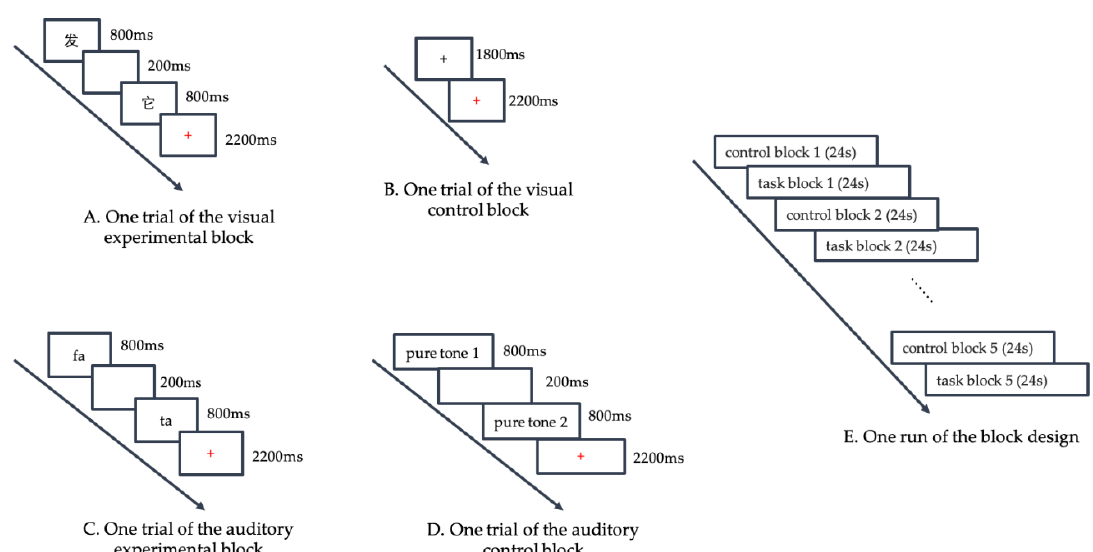
Figure 1. Functional magnetic resonance imaging (fMRI) Experimental Procedure. (Panel A ) displays one trial of the visual experimental block. Two words were displayed on the screen sequentially, with a 200-ms blank interval between them. Each word lasted for 800 ms. After the presentation of words, a red fixation cross was displayed on the screen, indicating the subjects to respond. (Panel B ) displays one trial of the visual control block, where a black fixation cross was displayed for 1800 ms, and then the black cross turned red, indicating the subjects to respond. (Panel C ) displays one trial of the auditory experimental block. Two words were broadcasted in stereo sequentially, with a 200-ms blank interval between them. Each word lasted for 800 ms. Then a red fixation cross was displayed on the screen, indicating the subjects to respond. (Panel D ) displays one trial of the auditory control block. Subjects heard two identical or different pure tones (each lasting 800 ms with a 200 ms blank interval between the two tones). When the red fixation cross appeared, the subjects were required to judge whether the two tones were the same. (Panel E ) displays one run of the block design. Each language run consisted of five experimental blocks and five control blocks, with each block lasting 24 s. The five experimental blocks were alternated with five control blocks.